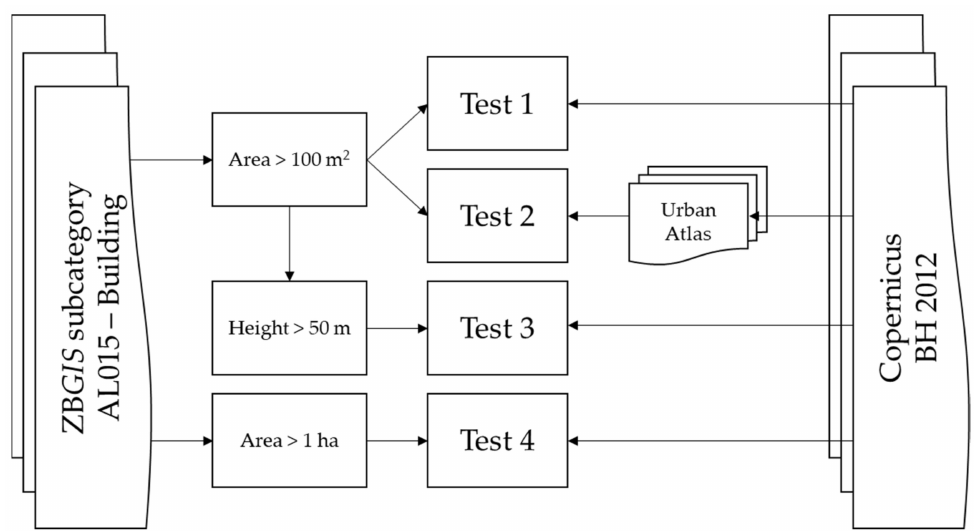
Figure 3. The research